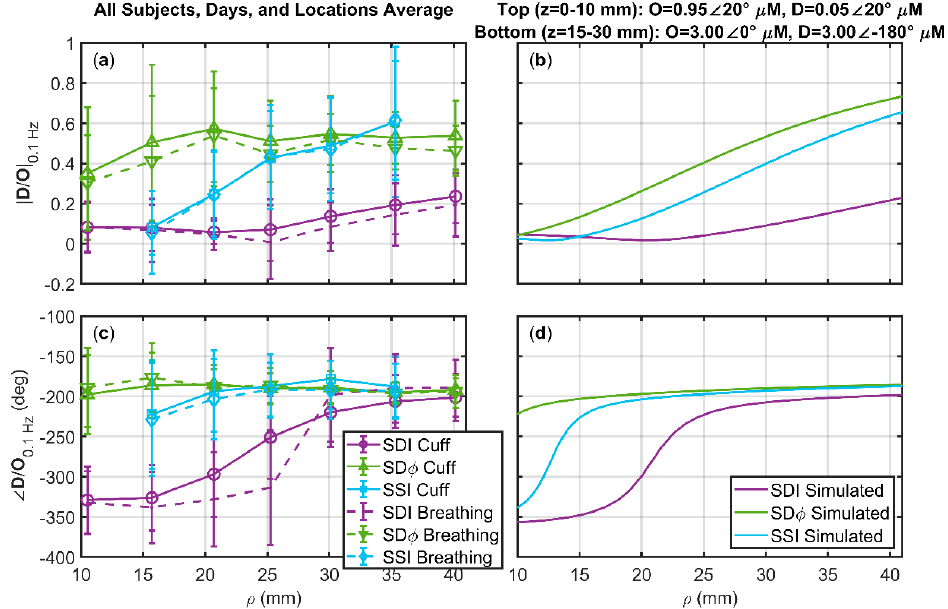
Figure 5. Amplitude ratio ( a , b ) and phase di ff erence ( c , d ) of deoxyhemoglobin ( D ) and oxyhemoglobin ( O ) phasors at 0.1 Hz as a function of source-detector separation ( ρ ). Experimental data in ( a,c ) represent the average over all subjects, days, and locations for cyclic thigh cu ff inflation (solid lines) and for paced breathing (dashed lines). Theoretical calculations in ( b,d ) are for a three-layered medium: top layer from z = 0–10 mm with D / O = 0.05 ∠ 0 ◦ ; intermediate layer from z = 10–15 mm with no oscillatory hemodynamics; bottom layer from z = 15–30 mm with D / O = 1.00 ∠ − 180 ◦ . Three analysis methods are shown single-distance intensity (SDI, purple), single-distance phase (SD φ , green), and single-slope intensity (SSI, cyan). SSI measurements refer to two sources spaced by 10 mm, plotted such that ρ is the average of the source-detector distances of the two sources. Note: Error bars show standard deviation of all analyzed pixels that show significant coherence in the wavelet transfer function scalogram across all subjects, days, and locations.